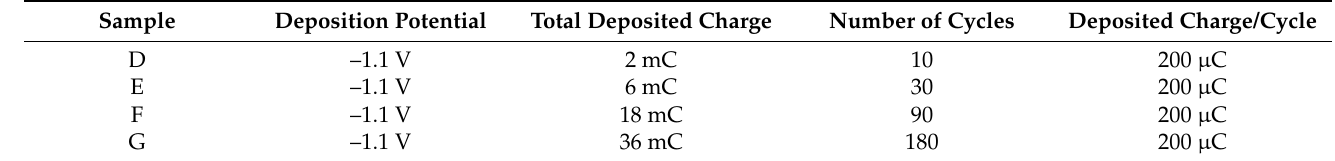
Table 2. Deposition parameters of samples D, E, F and G.